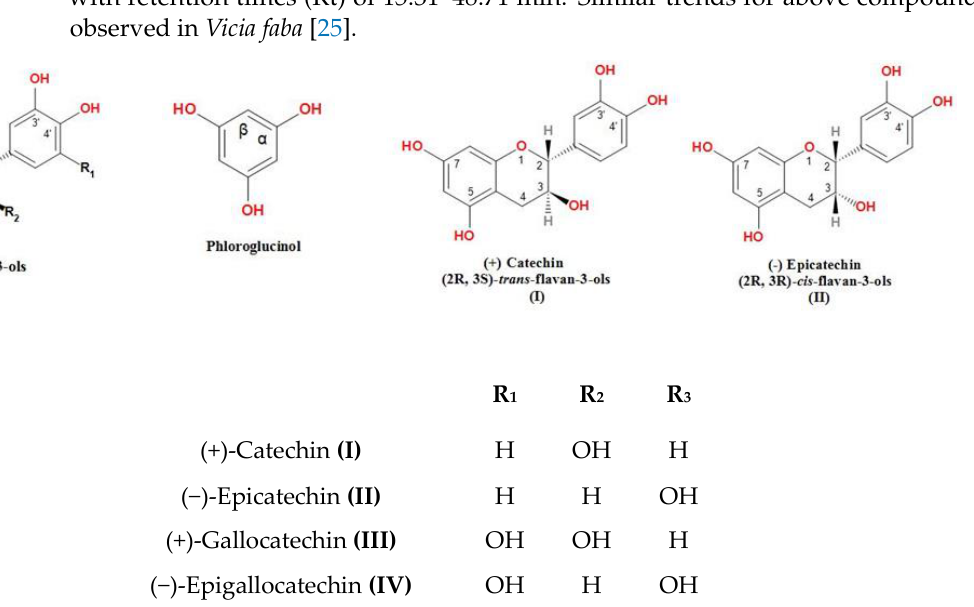
Figure 1. Chemical structure of the compounds investigated in the study. The highest (0.524 ± 0.03) and lowest (0.098 ± 0.01) catechin was found in FR-DW and FR-70, respectively, whereas it was not detected in FRL-DW and FR-50 (Table 1). A similar trend was observed for epicatechin. Gallocatechin and epigallocatechin was present at the greatest levels in FR-70 (0.458 ± 0.13) and FR-DW (0.315 ± 0.11), and lowest in FR-DW (0.035 ± 0.02) and FR-50 (0.016 ± 0.07). Similar results were reported in Litchi chinensis [26], Saracaasoca [27] and Ephedra sinica [28]. HPLC analysis of acid-catalyzed cleavage of the phloroglucinol adduct of different proanthocyanidins revealed flavan-3-ol in monomeric and adduct. All compounds varied in their polymeric structure and the degree of polymerization in the monomer and phloroglucinol adduct ratio. The observed ratios were recorded as: FRL-50, 3.06; FRL-DW, 3.99; FR-70, 5.09; FR-50, 3.46, and FR- DW, 2.63. The degree of polymerization helps to enhance the stability of metal-flavonoid complexes, and these initial metal-flavonoid complexes are very good cytoprotectives against superoxide radical scavenging [29]. Furthermore, the adduct represented the extender unit (EU), whereas the terminal unit (TU) of the molecule was represented by monomers corresponding to the 4 β linkage in the molecule. FRL-50 consisted of 24% TU and 76% EU. FRL-DW had 20% TU and 80% EU (Table S1). Proanthocyanidins FR-70, FR-50, and FR-DW possessed EU 84, 78, and 68% and TU 16, 22, and 32%,